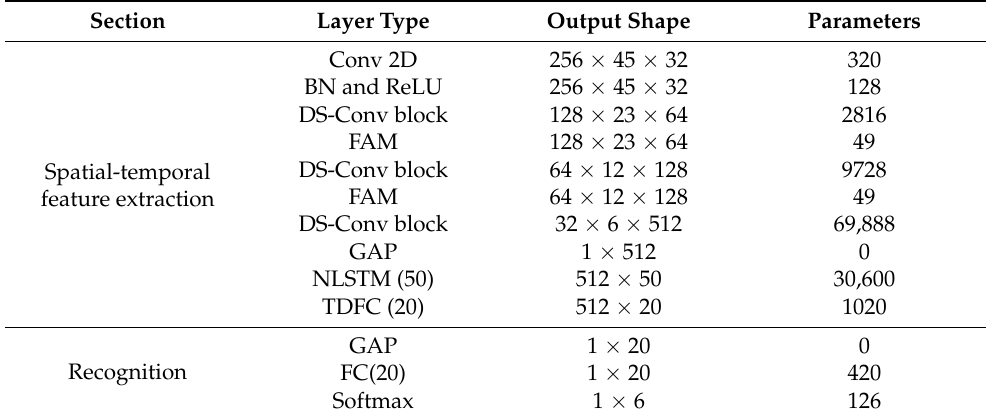
Table 3. Summary of the STC-NLSTMNet